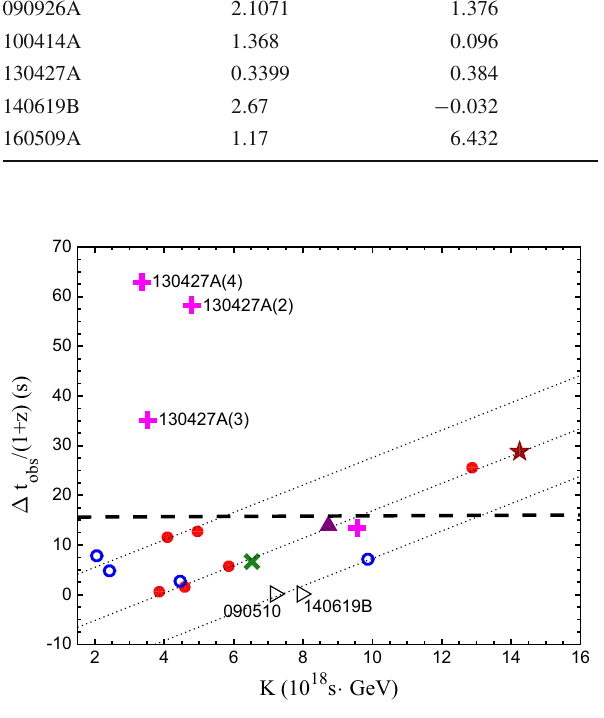
Fig. 2 The Δ t obs /( 1 + z ) – K plot for all the events in Table 1. Two hollow triangles refer to two events from short bursts, while the others come from long bursts. We obtain this plot by analyzing the light curves in Band-Obs. The hollow circles refer to events of GRB 080916C. The solid circles refer to events of 090902B. The plus signs refer to events of GRB 130427A. The cross refers to the event 090926A. The solid triangle refers to 100414A and the star refers to 160509A. The three parallel dotted lines are suggested in Refs. [7,8]. The dashed line is the fit of all